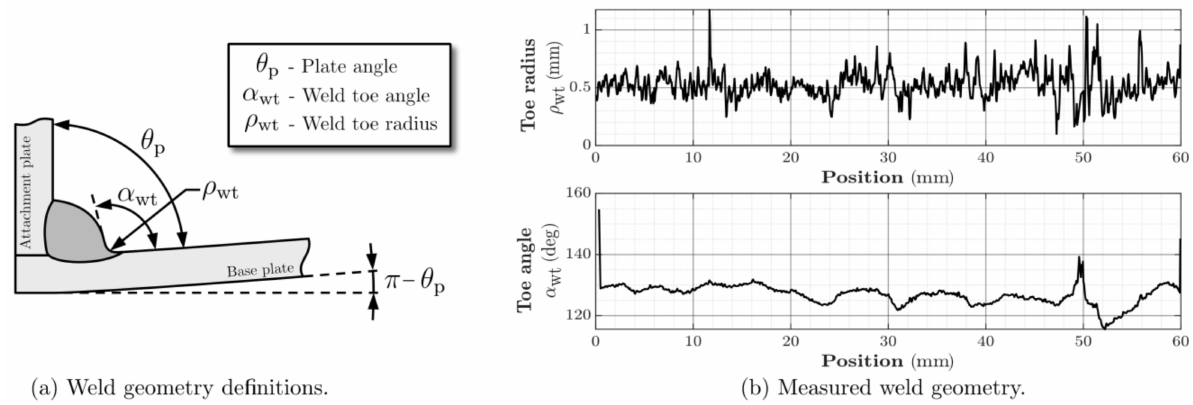
Figure 4. ( a ) Weld geometry definitions and ( b ) variation measured by the Winteria ® qWeld [32] system for specimen